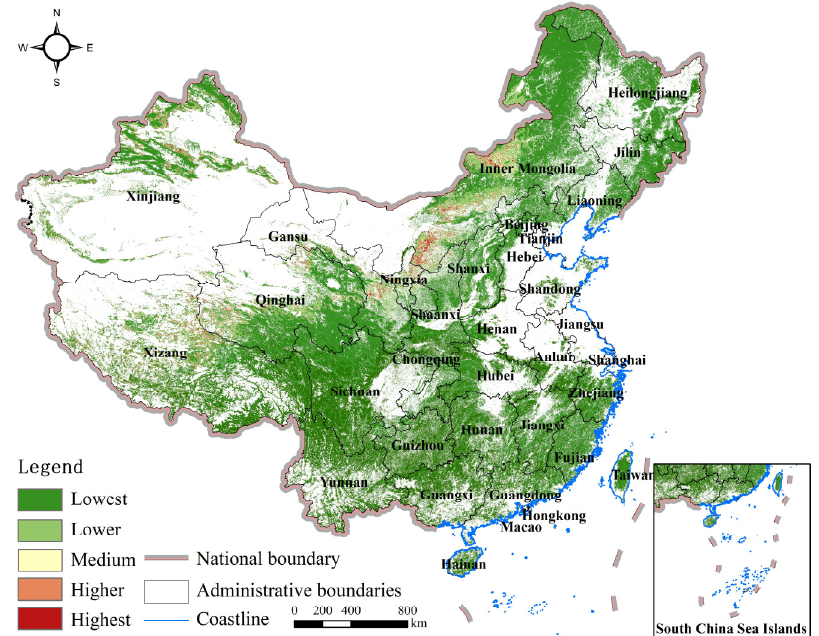
Figure 9. Spatio-temporal stability of CS in CES.